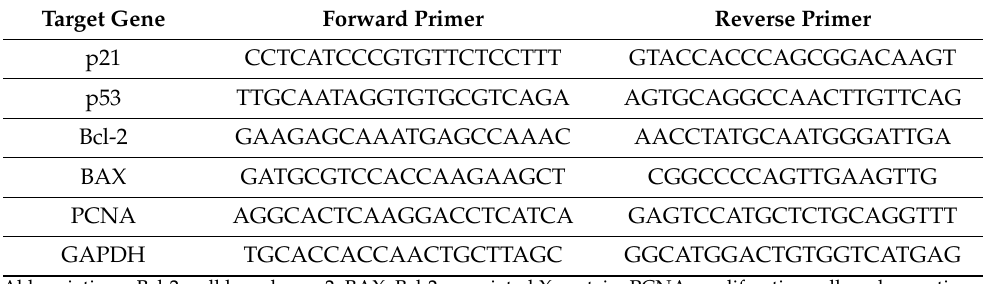
Table 1. Primer sequences for the investigated